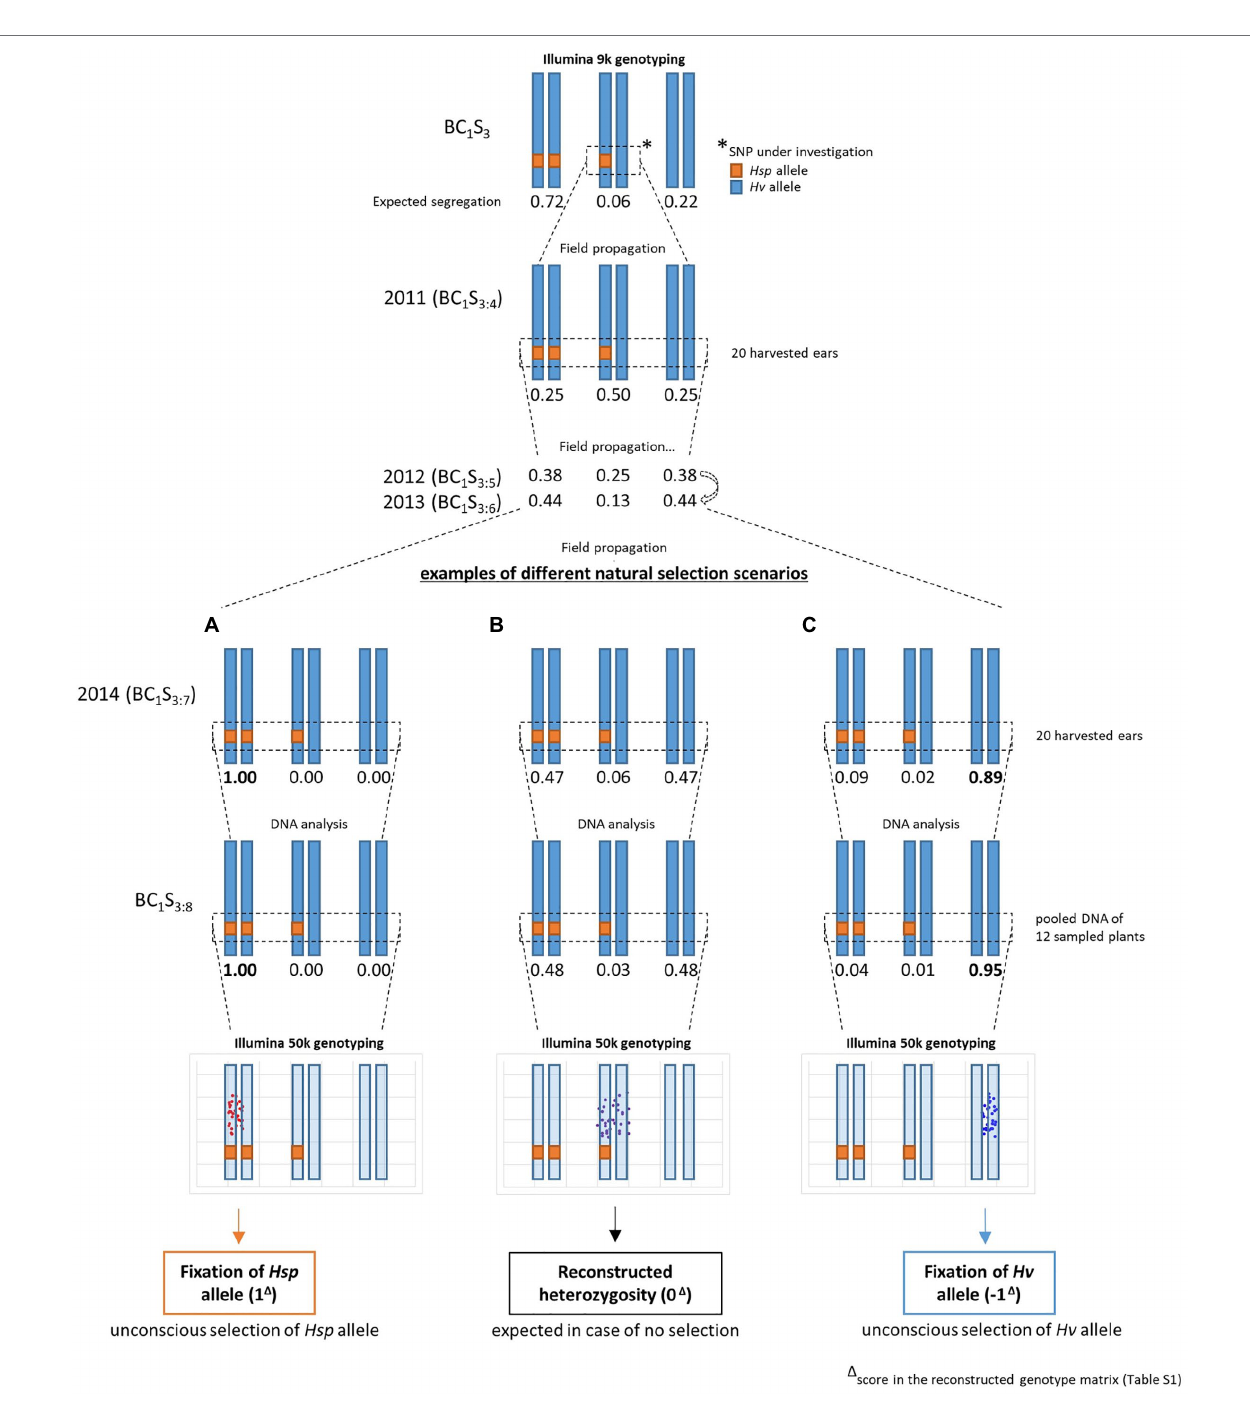
FIGURE 1 | Population conservation and sampling strategy from generation BC 1 S 3 to BC 1 S 3:8 . Exemplified for one heterozygous SNP in BC 1 S 3 , which is traced through four seasons of field propagation (2011–2014) followed by pooled DNA sampling of 12 seedlings in BC 1 S 3:8 . Heterogeneity within these 12 seedlings leads to heterozygous allele calls in Illumina 50 k genotyping and is termed “reconstructed heterozygosity”. The expected segregation of a single SNP in HEB-25 generation BC 1 S 3 is equal to 71.875% homozygous Barke, 6.25% heterozygous, and 21.875% homozygous wild barley. Without selection, the expected SNP segregation of the offspring of a heterozygous HEB-25 plant in generation BC 1 S 3:8 is equal to 48.4375% homozygous Barke, 3.125% heterozygous, and 48.4375% homozygous wild barley, giving rise to a reconstructed heterozygous genotype B , resulting in a score of 0 in the reconstructed genotype matrix; Supplementary Table S1 ). A and C indicate different possible scenarios of allele distribution in case of selection for Hsp allele A , resulting in a score of 1 in the reconstructed genotype matrix) or Hv allele ( C , resulting in a score of − 1 in the reconstructed genotype matrix) in previous generations (here exemplified for BC 1 S 3:7 ). Note that a homozygously fixed allele call in Illumina genotyping can be obtained despite the presence of small amounts of opposite alleles in the pooled sample C